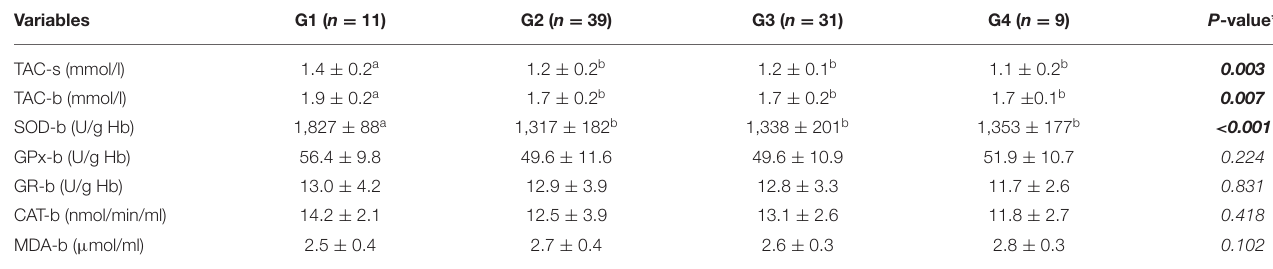
TABLE 3 | Antioxidant status parameters (mean ± SD).